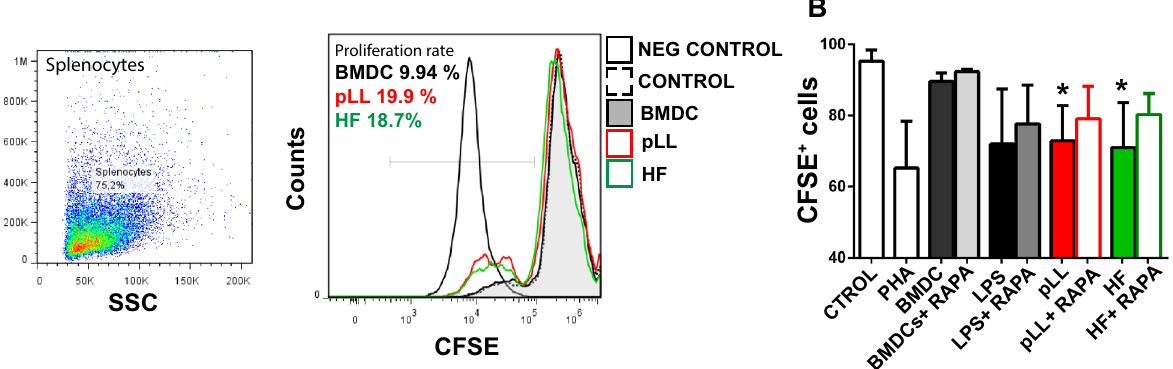
Figure 4. Purified laminar layer or hydatid fluid-stimulated BMDCs induce in vitro splenocyte proliferation. ( A ) Resting splenocytes were labeled with 1 μM CFSE and co-incubated with unstimulated BMDCs (BMDC) or pre-stimulated with, LPS, pLL or HF in presence or absence of rapamycin (20 nM) using a DC: splenocyte ratio of 1:4 and cultured in 96-well flat-bottomed plates in a final volume of 200 μl for 4 days. Splenocytes not labeled with CFSE (NEG CONTROL), without co-incubation with BMDCs (CONTROL) or treated with 1 μg/ml of phytohaemagglutinin (PHA) were used as controls. Cells were harvested and analyzed for CFSE content by flow cytometry. A representative histogram from one of five independent experiments, each done at least in duplicate is shown ( B ) Bar graph showing the significant differences of the experiments performed (one-way ANOVA test ***p < 0.001 and Tukey post hoc test *p < 0.05 for pLL or HF- pre-stimulated BMDCs vs